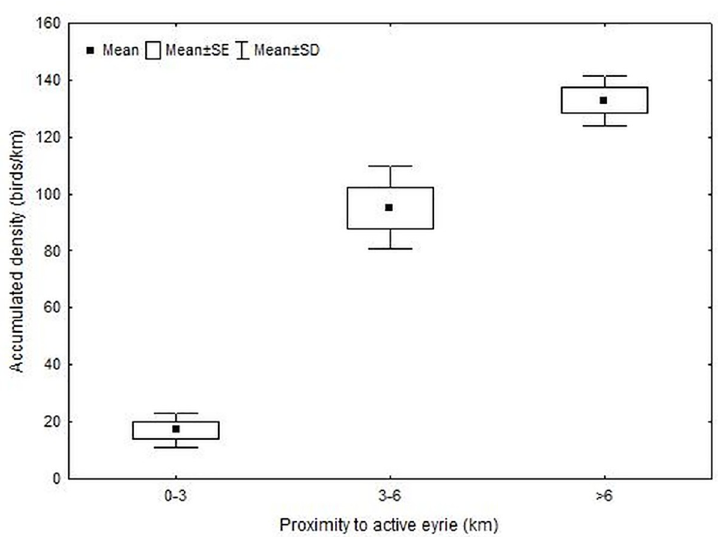
Fig 3. Accumulated density of red knots along beaches according to their proximity (0–3, 3–6, > 6 km) to active peregrine falcon eyries. Accumulated densities represent the sum of all surveys (6 weekly surveys/year) within each year divided by the length of beaches within proximity categories. Means and standard errors are presented for proximity categories across years.